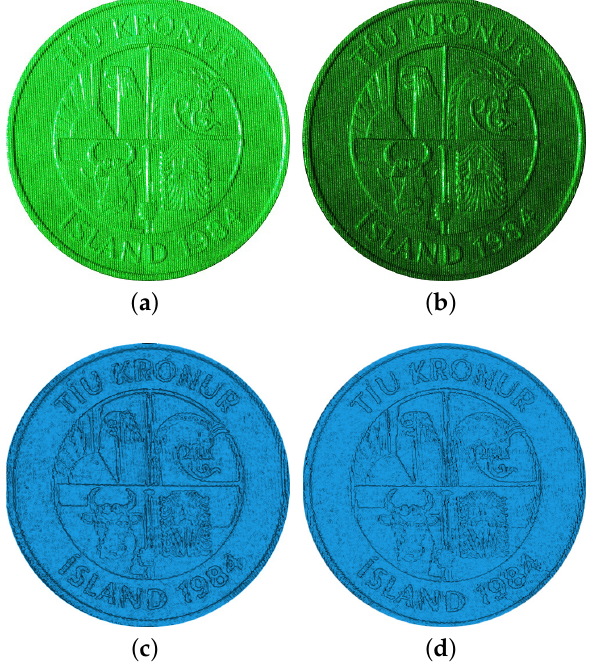
Figure 4. Illuminated coin and its retrieval as background illuminance E = 0 Lux for indoor measurement. ( a ) without filtering; ( b ) with filtering; ( c ) retrieval using the image of ( a ); ( d ) retrieval using the image of ( b ).